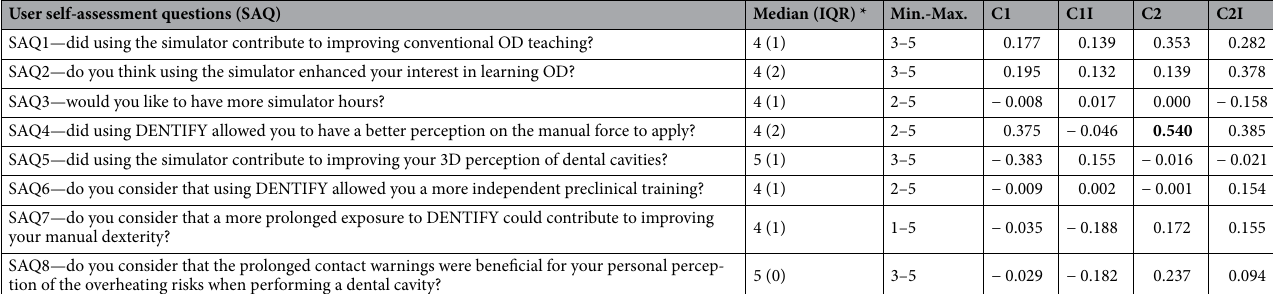
Table 3. User self-assessment evaluation. * IQR interquartile range. Correlation between performance (drill time (s)) and answers to the user self-assessment questions (SAQ). Statistically significant correlations (p < 0.05) are denoted in bold.